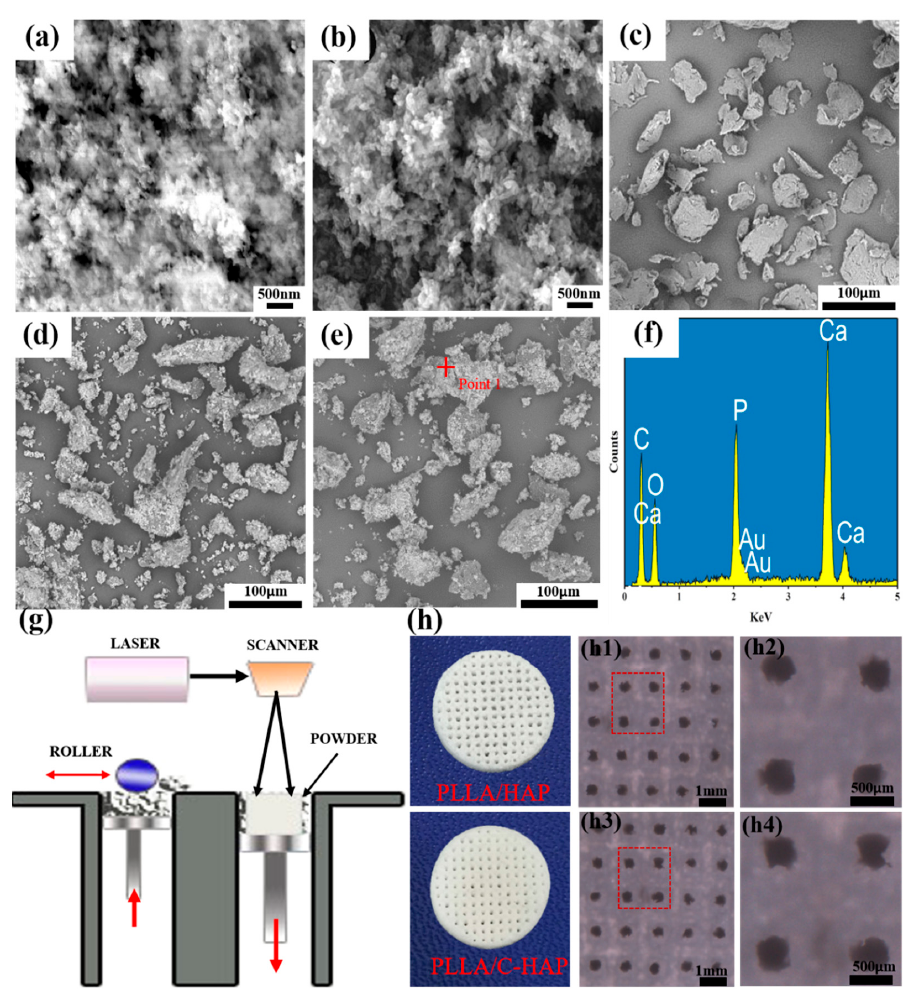
Figure 2 . SEM morphology of ( a ) HAP nanoparticles, ( b ) C-HAP nanoparticles, ( c ) PLLA powder, ( d ) ( d ) PLLA / HAP powder and ( e ) PLLA / C-HAP powder, ( f ) EDS spectra of p1 site in ( e ), ( g ) Sca ff old PLLA / HAP powder and ( e ) PLLA/C-HAP powder, ( f ) EDS spectra of p1 site in ( e ), ( g ) Scaffold fabricating via SLS, ( h ) Morphology of PLLA / HAP and PLLA / C-HAP sca ff olds and the corresponding fabricating via SLS, ( h ) Morphology of PLLA/HAP and PLLA/C-HAP scaffolds and the corresponding SEM images . SEM